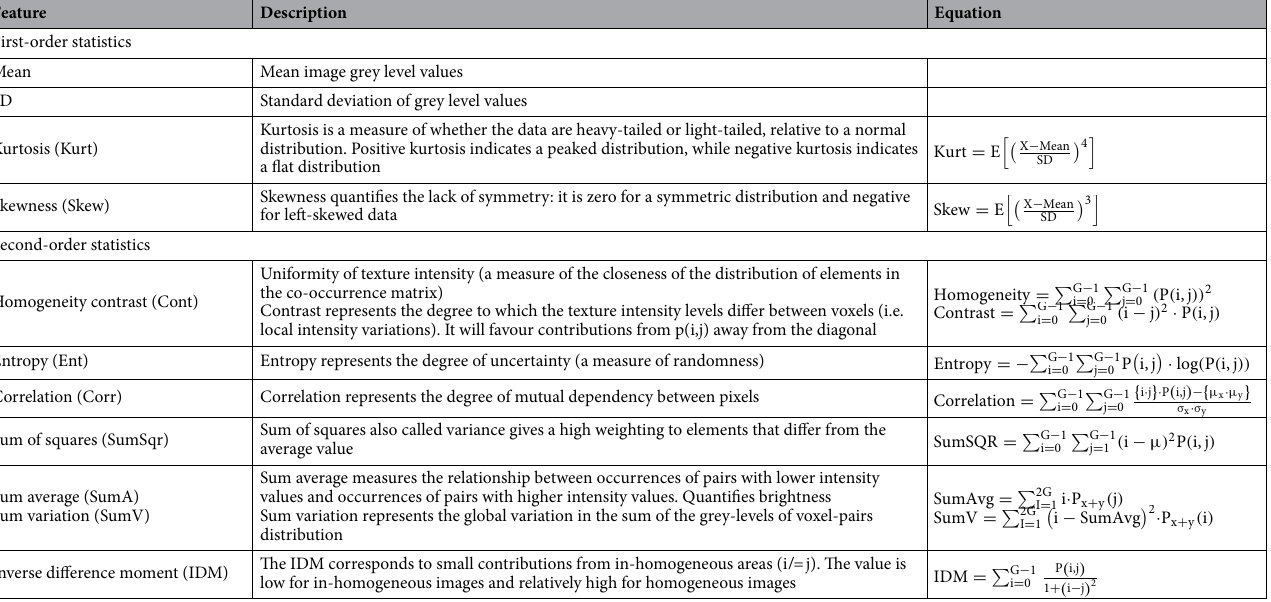
Table 4. Texture features considered, together with their significance, equations and models. G number of grey levels used, I intensity value of a neighbour voxel, j intensity value of a reference pixel, P(i,j) probability of the appearance of the (i,j) pair in the co-occurrence matrix, µ m ean value of P, P x and P y marginal probabilities, σ x . σ y SD of P x and P y , respectively. P x + y = (cid:31) G − 1 i = 0 (cid:31) G − 1 j = 1 P ( i, j ) , i + j = k for k =